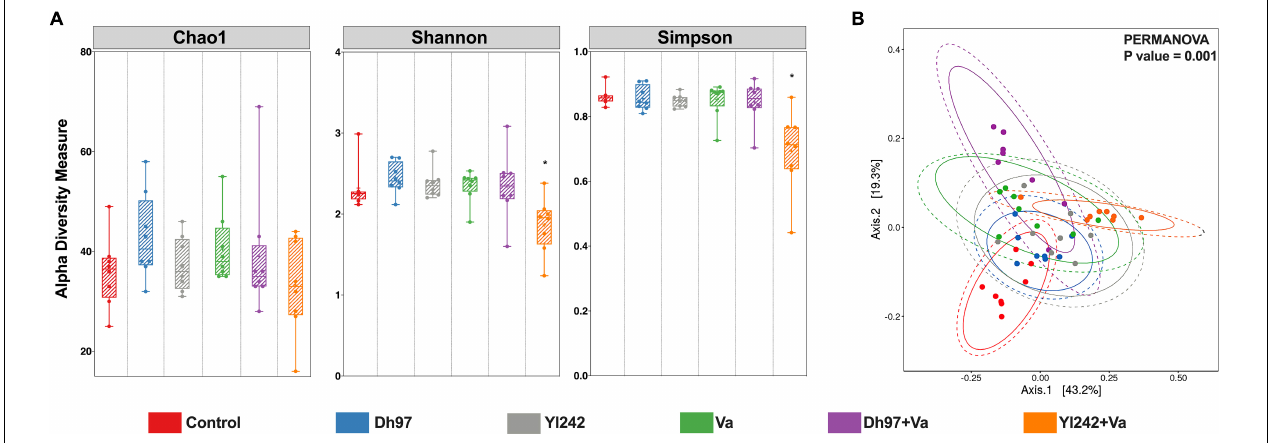
FIGURE 2 | Bacterial diversity analyses of Tg(Bacmpx:GFP) i 114 larvae inoculated with yeasts and/or V. anguillarum . (A) Alpha diversity indexes Chao1, Shannon, and Simpson. (B) Principal coordinate analysis (PCoA) based on weighted Unifrac distance matrix plot. Analysis of the bacterial microbiota was performed in Tg(Bacmpx:GFP) i 114 zebrafish larvae at 8 days post fertilization (dpf), corresponding to 3 days post V. anguillarum infection. Control group: non-inoculated conventionally raised larvae (CONV-R). Dh97 and Yl242 groups: CONV-R larvae inoculated by immersion with 5 × 10 6 CFU/mL of D. hansenii 97 or Y. lipolytica 242, respectively, at 4 dpf. Va group: CONV-R larvae challenged at 5 dpf by immersion with 10 7 CFU/mL of V. anguillarum . Dh97 + Va and Yl242 + Va groups: CONV-R larvae inoculated by immersion with both yeasts at 4 dpf and challenged with V. anguillarum at 5 dpf. ∗ p <